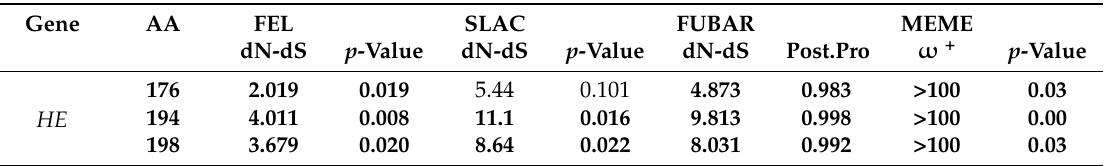
Table 2. Sites under positive